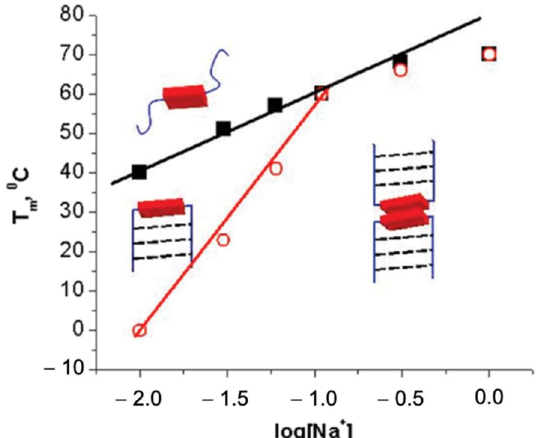
Figure 10. Effect of sodium concentration on temperature-dependent dissociation of DNA base pairs (black) and PDI–PDI dimer (red) [80]. Copyright © 2009, American Chemical